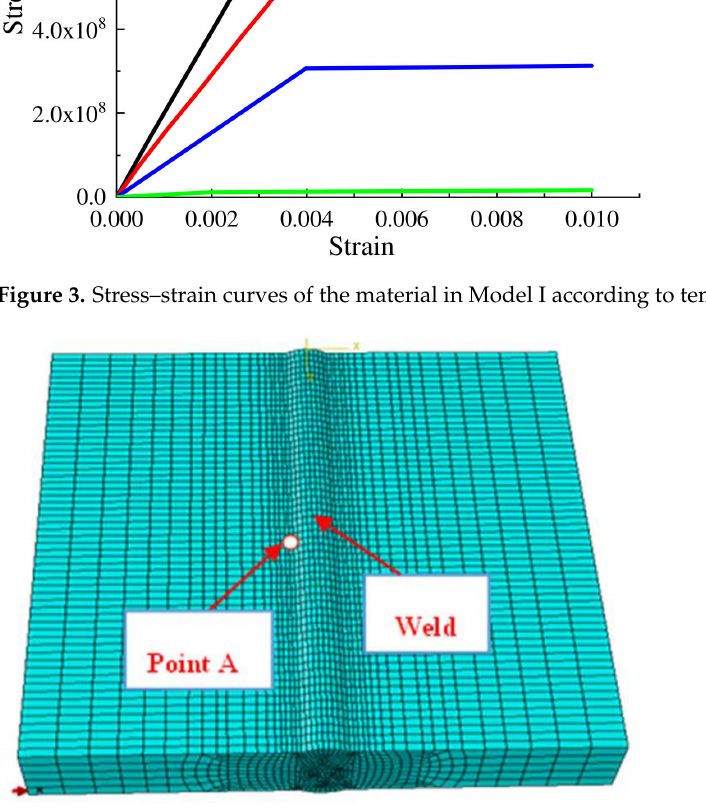
Figure 4. Finite element model and mesh division of Model